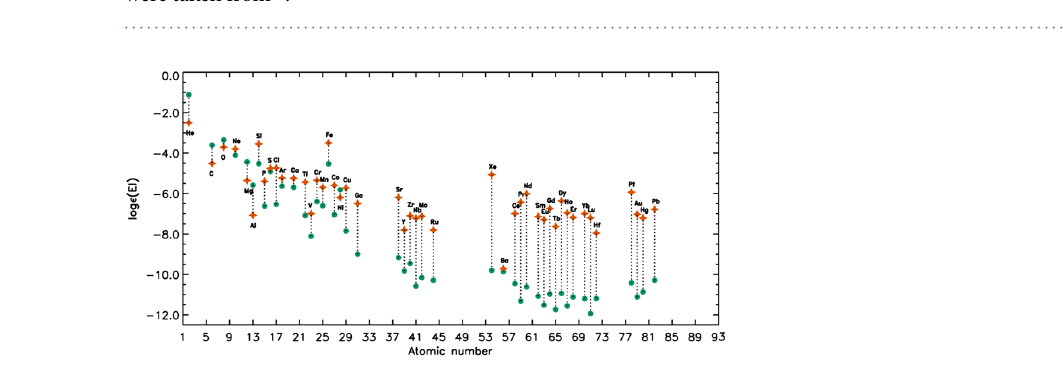
Table 2. Chemical abundances (log N/N tot ) and standard deviations for individual elements. Number of individual lines and blends analysed is given in parentheses behind the abundance values. Solar abundances were taken from 38 .